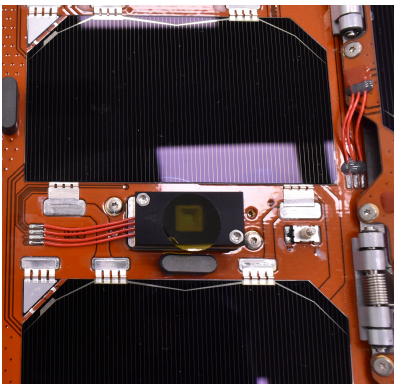
Figure 7. GomSpace FSS sun sensor integrated on the solar array. Note the Kapton layer to protect the sensor’s hole. Photo courtesy of DHV